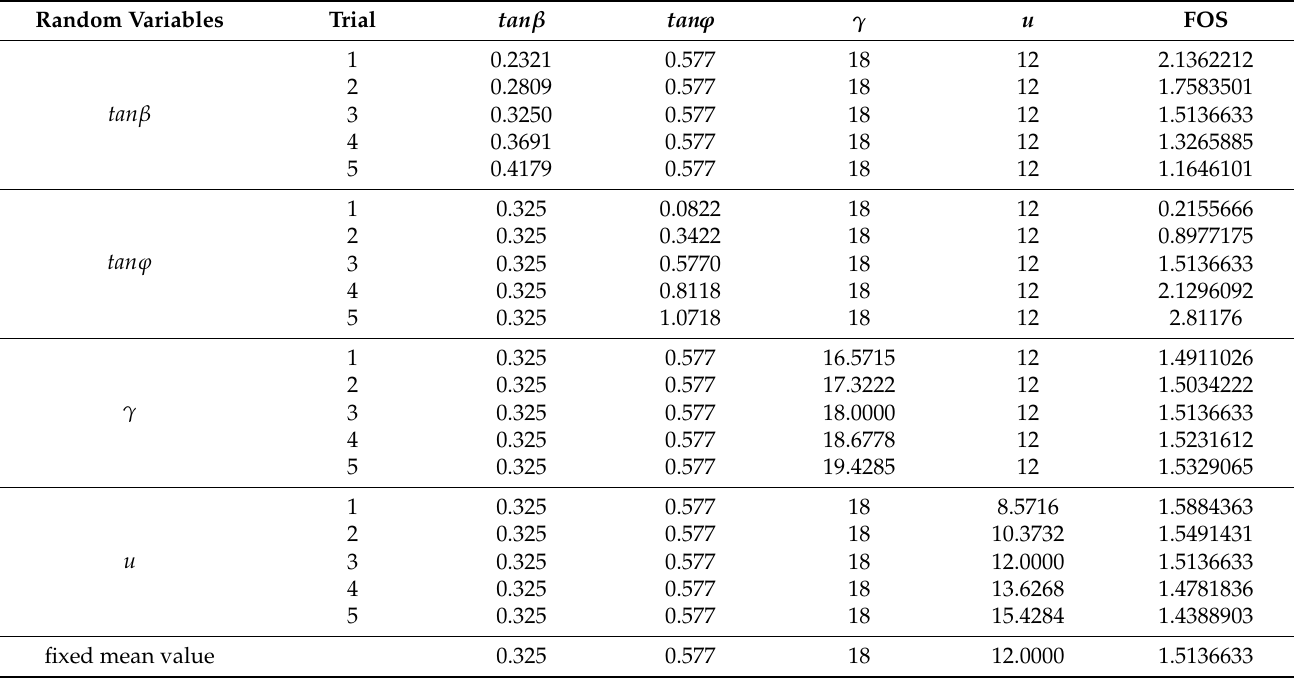
Table 7. Input grid and corresponding safety